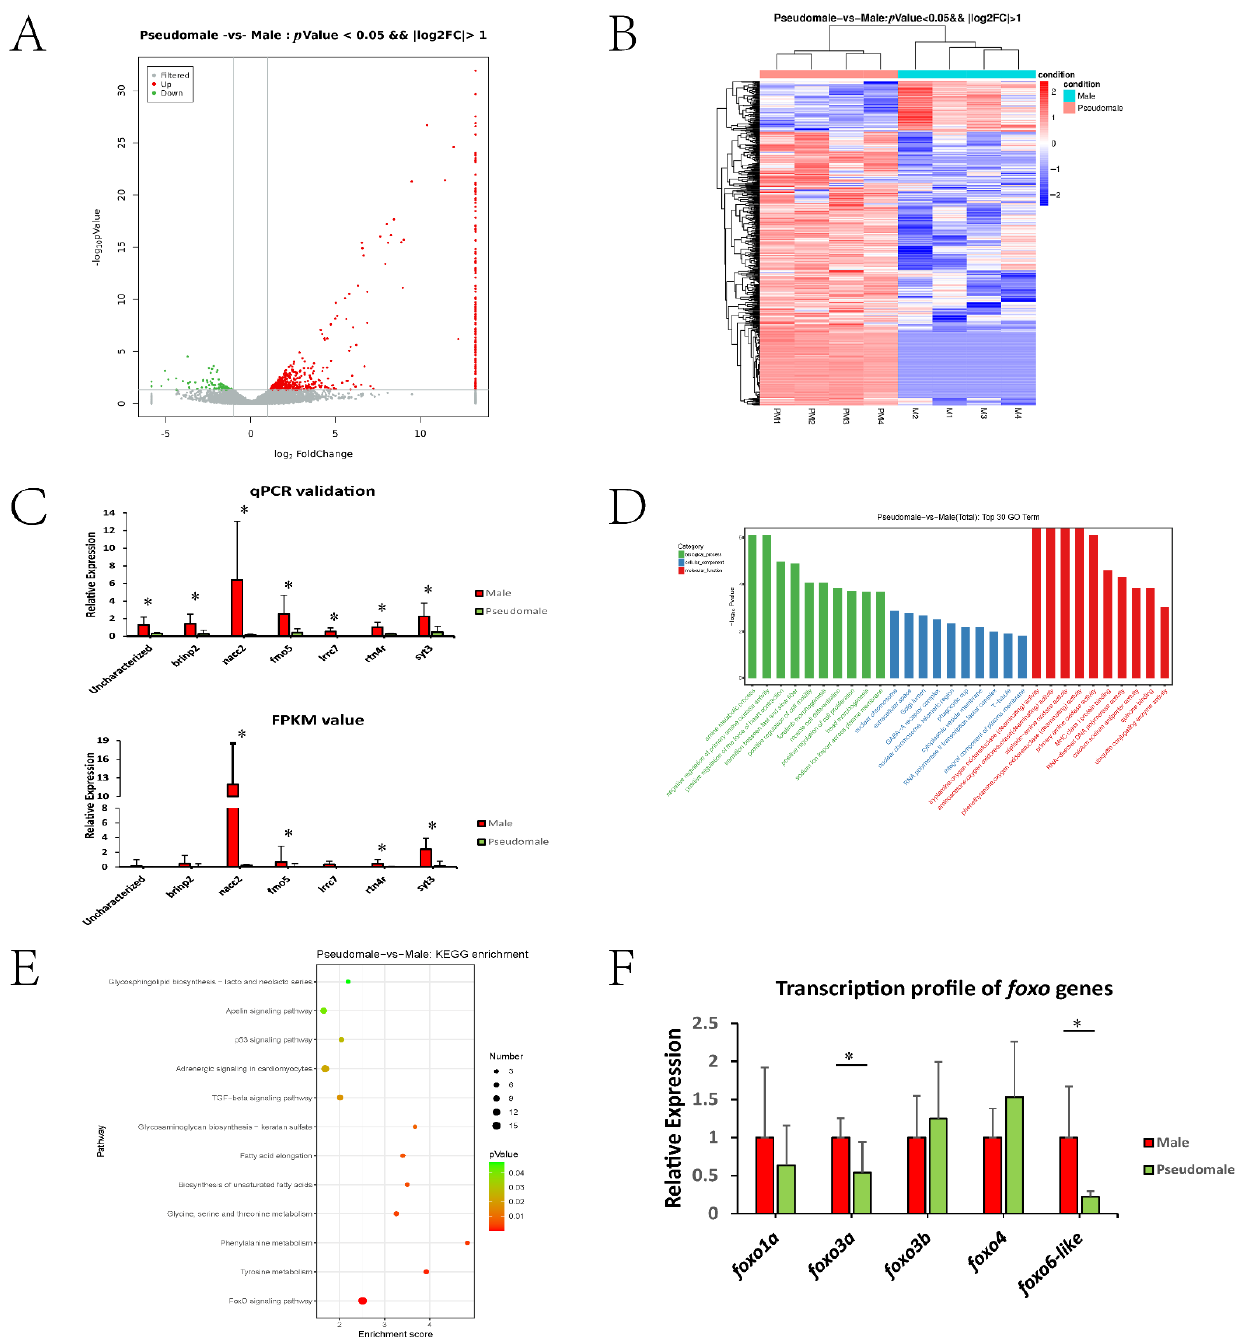
Figure 1. ( A ) Volcano plot of DEGs. ( B ) Heat map of DEGs. ( C ) qPCR and transcriptomic profile of seven randomly selected genes between male and pseudomale sperm. GO ( D ) and KEGG analysis ( E ) of DEGs between the pseudomale and male sperm transcriptomes. ( F ) The transcription profile of five foxo genes between the male and pseudomale sperm. * indicated significant differences ( p < 0.05).